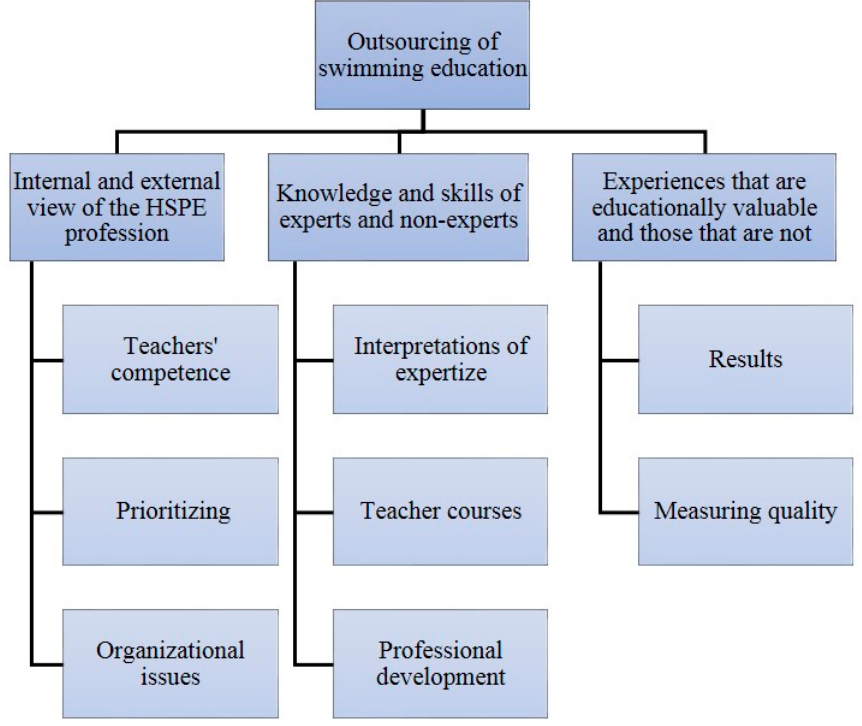
Figure 1. Research aim (1st row), research questions (2nd row), and analytic themes (3rd–5th row). HSPE = Health, Sport, and Physical Education.